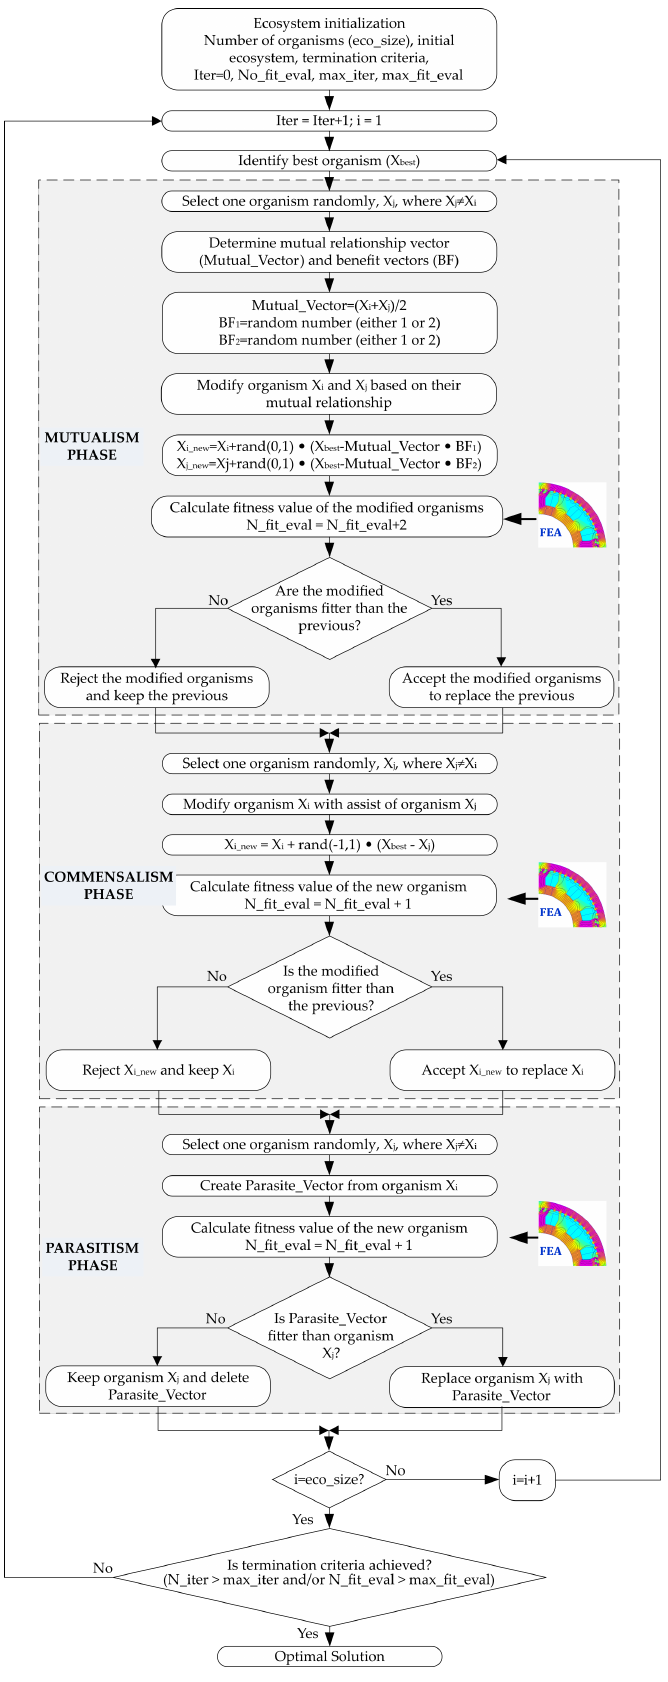
Figure 15. Detailed flowchart of SOS algorithm implemented and applied to ORDSPMG